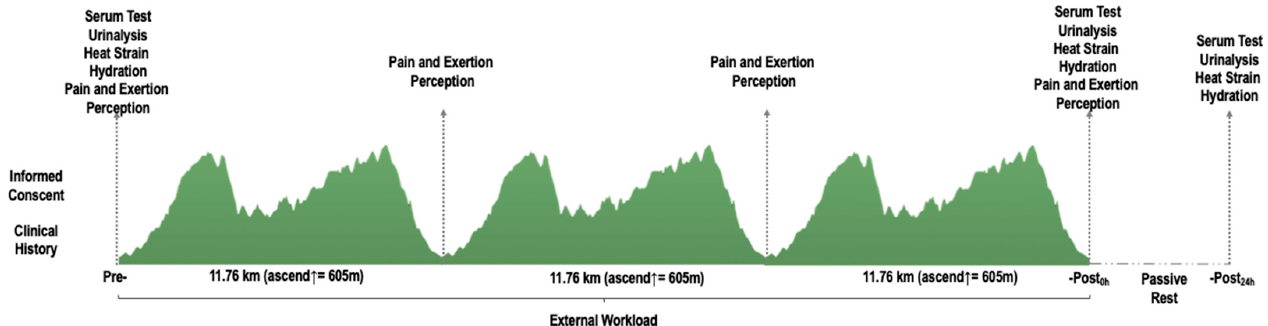
Figure 1. Schematic design of study variables with measurement time and trail altimetry.